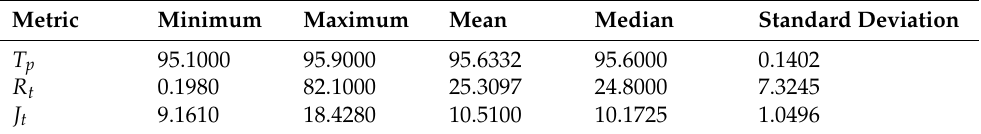
Table 3. Descriptive statistics for T p , R t and J t (over 900 samples) for the UDP DDoS flooding attack scenario.